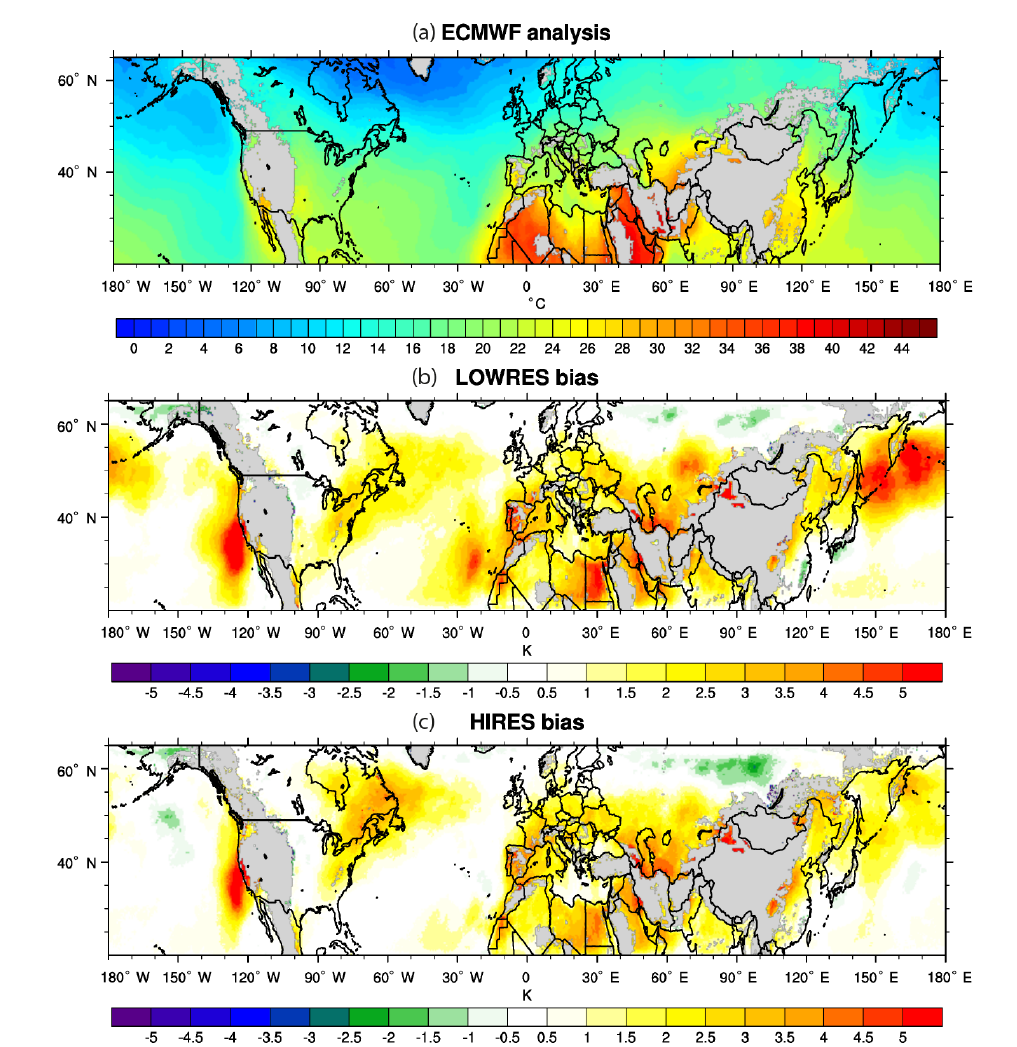
Figure 12. Mean 925hPa temperature for 12:00UTC of the ECMWF analysis (a) . Panels (b) and (c) show the deviation of the LOWRES and HIRES simulations from the ECMWF analysis,